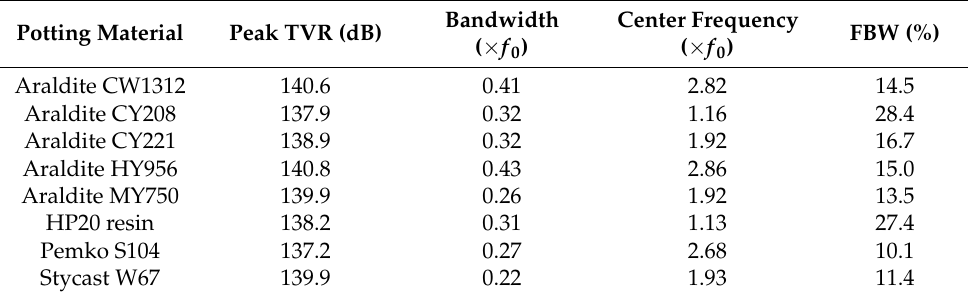
Table 3. Acoustic characteristics of the array potted with epoxy materials.